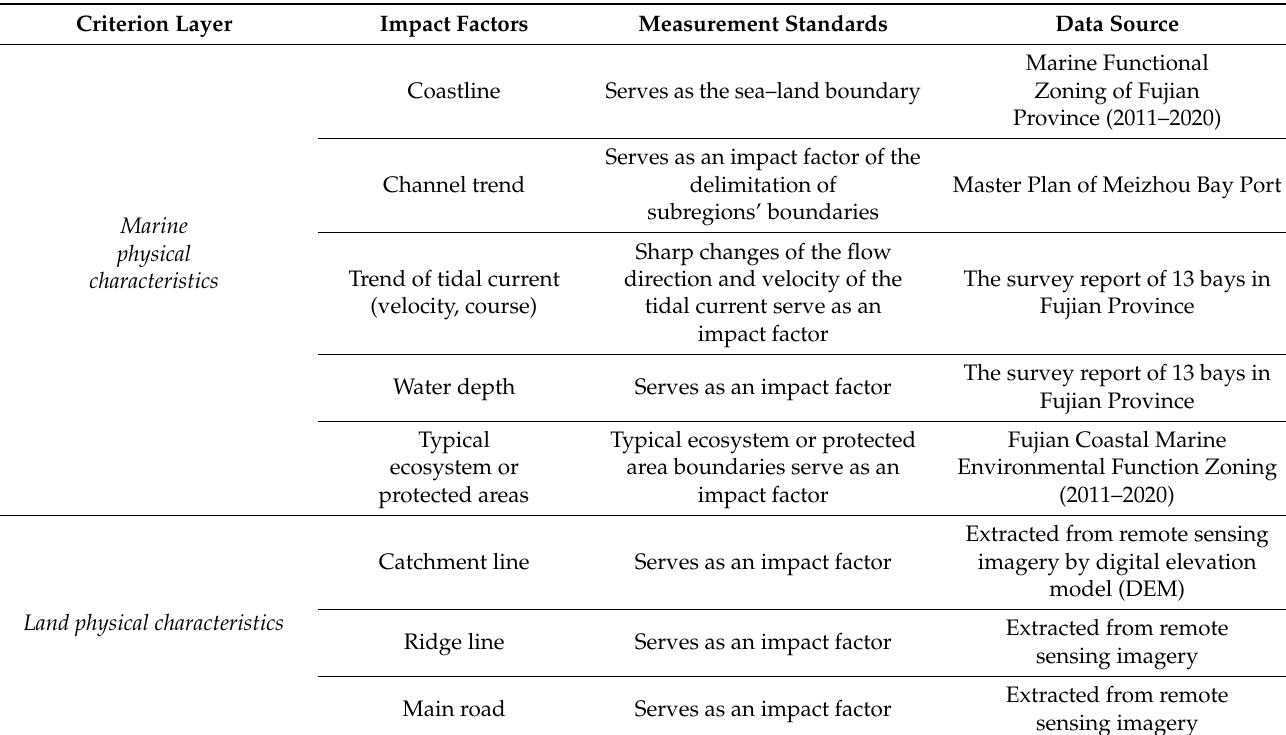
Table 1. Impact factors of the delimitation of subregions’